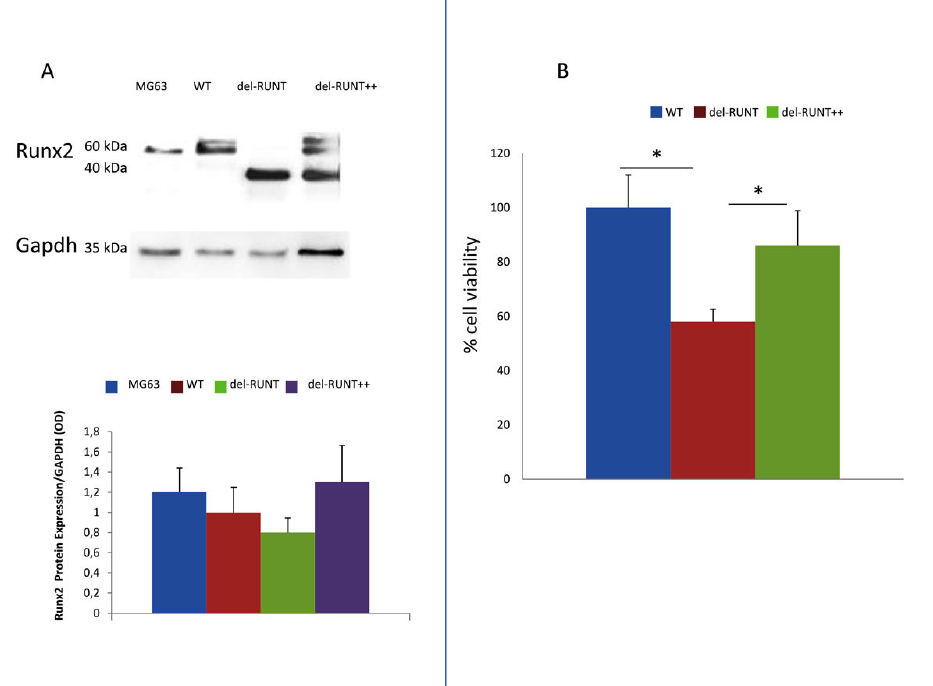
Figure 6. Western blot analysis of del-RUNT clones. MG63: osteosarcoma cell line (used as positive control for Runx2 protein); WT: A375 cell line; del-RUNT, clone with inframe deletion of RUNT; del-RUNT++: same clone, reexpressing wild-type RUNX2 after transduction with Lenti ORF viral vector. GAPDH, internal control used to normalize protein expression. The re-expression of the wild protein after transduction with Lenti ORF viral vector particles expressing RUNX2 ( A ) induced an increased cell viability compared to del-RUNT cells ( B ). (Data were obtained by three independent experiments * p <